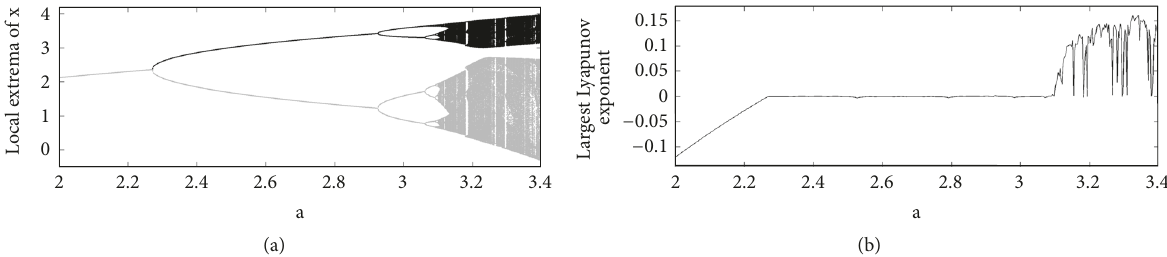
Figure 3: The bifurcation diagrams depicting the local maxima (black dots) and local minima (gray dots) of 𝑥(𝑡) (a) and the largest Lyapunov exponents (b) versus the parameter 𝑎 for 𝑏 = 3 .